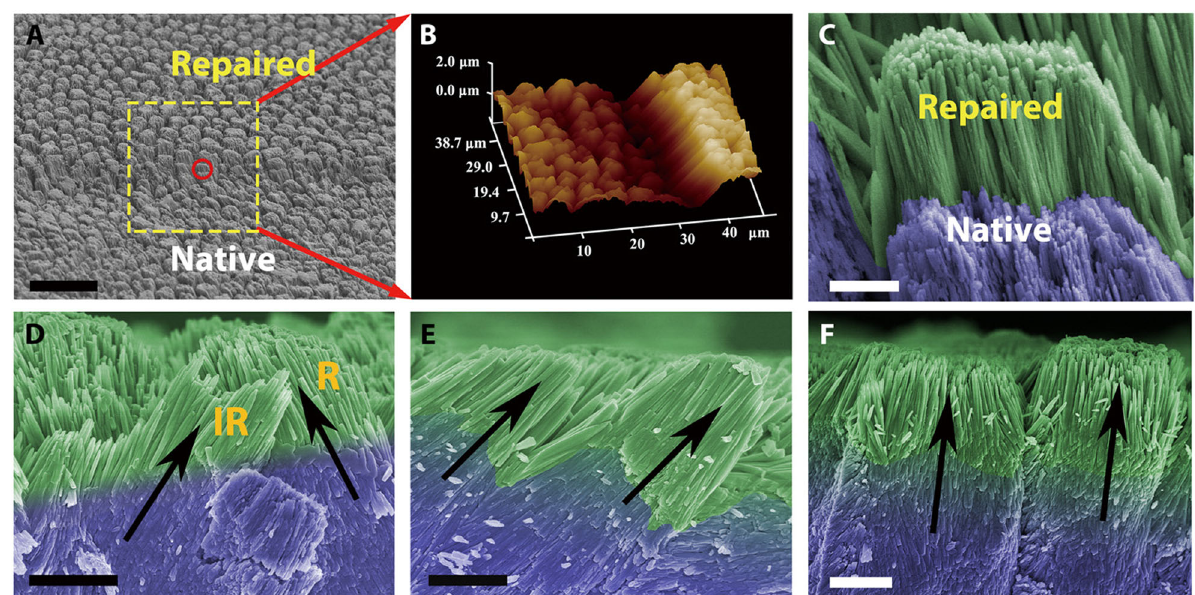
Fig. 7 Restoration of the complicated structure of enamel by TEA. A SEM image showing both etched enamel and repaired enamel. B A three-dimensional atomic force microscopy (AFM) image of repaired enamel. C High-magni fi cation SEM image of the red circle in ( A ). D Cross-sectional view of fi nal repaired enamel, where both enamel rods and inter-rods were repaired. Rods and IR represent for enamel rod and inter-rod, respectively. E, F Enamel rods with different orientations can be repaired